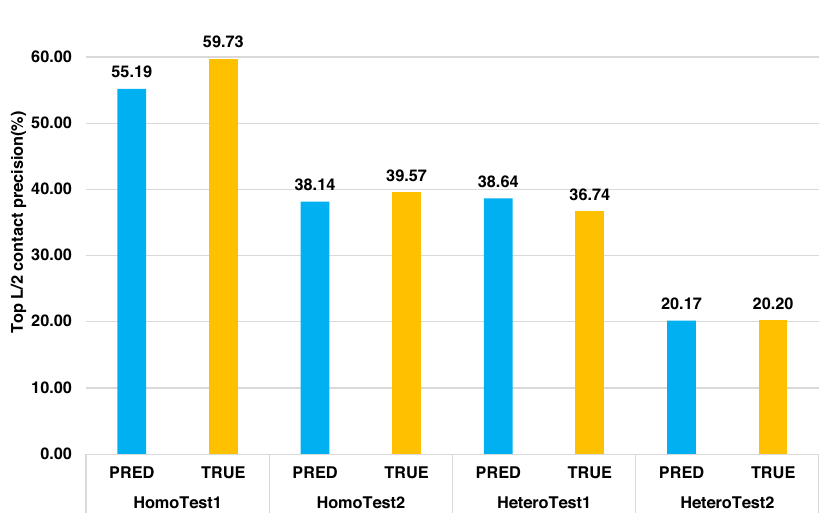
Fig. 3 | Comparisonofusing AlphaFold-predictedtertiary structure (blue) and truetertiarystructure(yellow)togenerateintra-chaindistance mapsasinput for predicting inter-chain distance maps on the four datasets. Top L/2 contact prediction precision on the datasets is